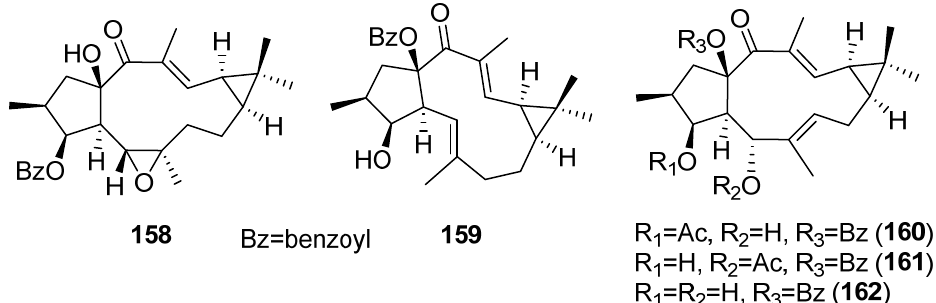
Figure 29. Lathyrane diterpenoids from E. micractina with vascular-relaxing activity.